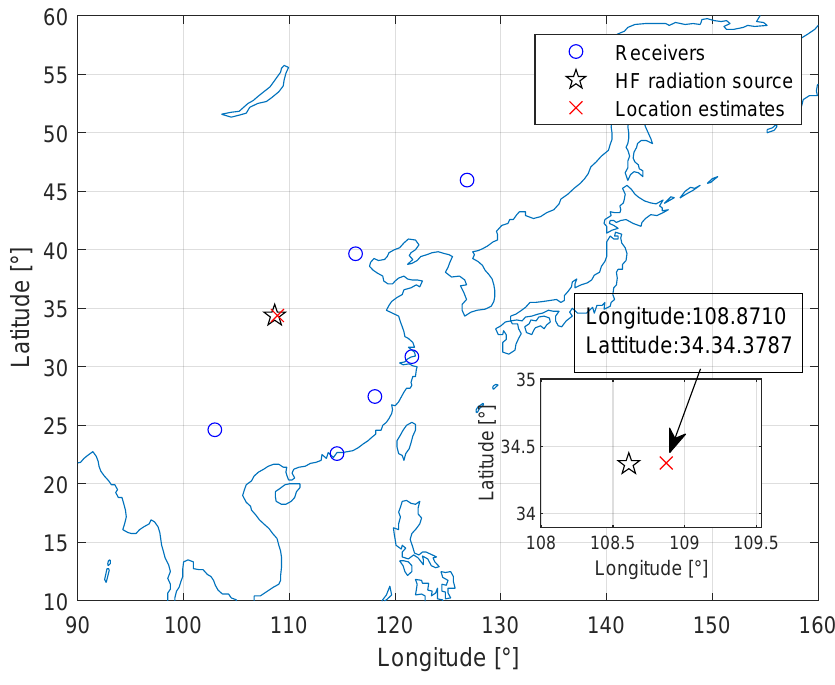
Figure 9. Experimental results of Xi’an HF source geolocation estimation.